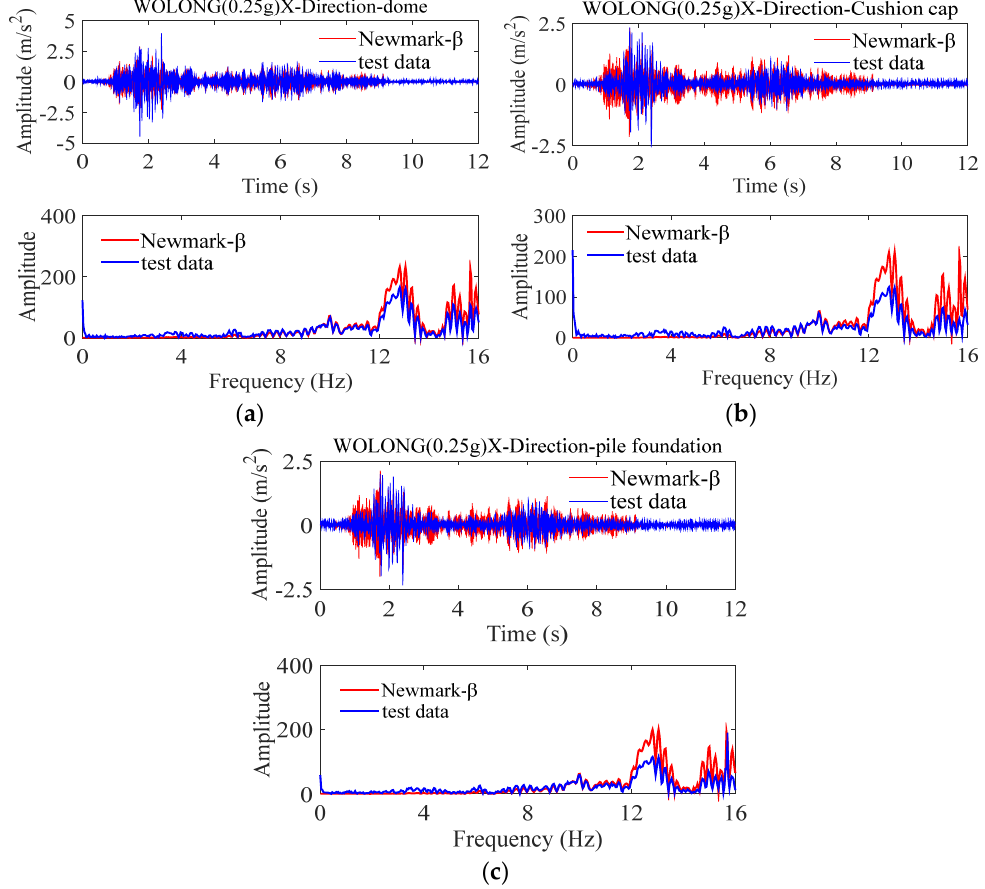
Figure 11. Comparison of shaking table test data and theoretical solution under the Wolong wave: ( a ) dome acceleration time history and spectrum comparison; ( b ) cushion cap acceleration time history and spectrum comparison; ( c ) pile foundation acceleration time history and spectrum comparison.